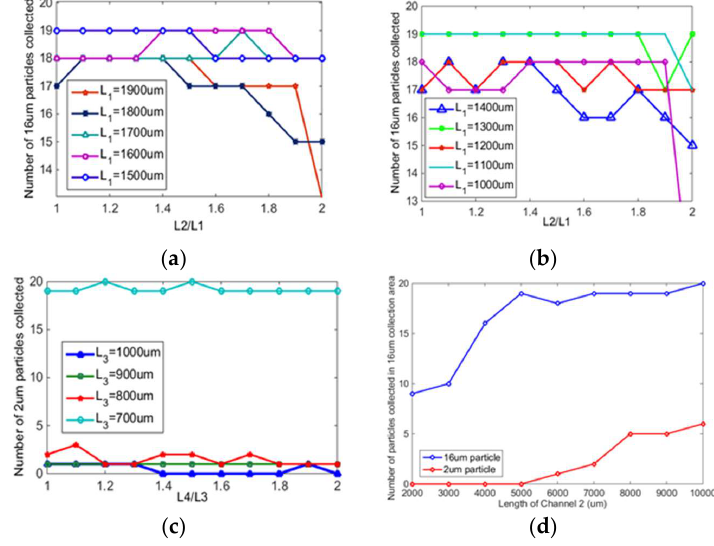
Figure 4. ( a,b ) Separation and enrichment of 16  m particles; ( c ) separation and enrichment of 2  m Figure 4. ( a , b ) Separation and enrichment of 16 µ m particles; ( c ) separation and enrichment of 2 µ m particles; ( d ) effect of channel 2 length on particle separation and enrichment. particles; ( d ) e ff ect of channel 2 length on particle separation and